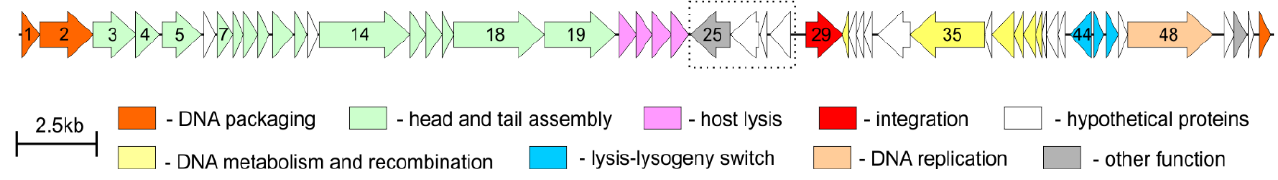
Figure 2. Genome map and functional annotation of the predicted ORFs of the VarioGold phage. Each arrow represents an ORF and its direction corresponds to the direction of gene transcription. The numbers on arrows refer to the ORF number in the genome, e.g., 1 — VG_p01 . The white color of arrows refers to genes encoding proteins with unknown function. The dotted line indicates a cluster of genes (including VG_P25 encoding O-antigen ligase) that are predicted to be jointly regulated and expressed in the VarioGold prophage (putative moron-like genes).